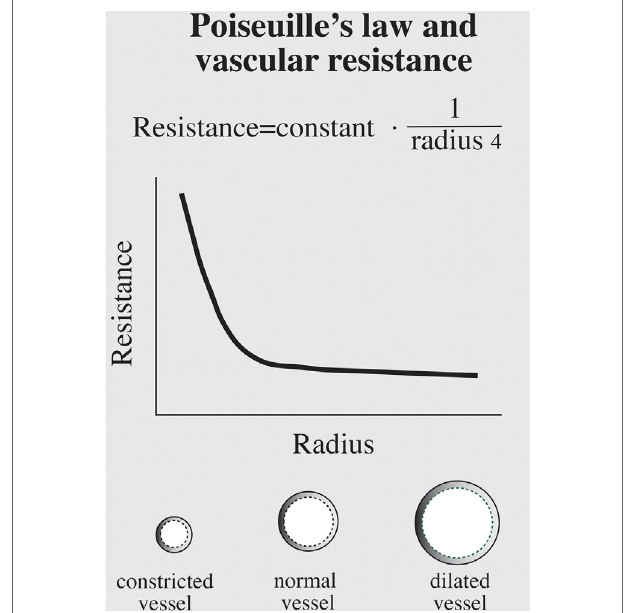
FiGURe 5 | The relation between the flow resistance ( R ) and radius ( r ) of a vessel according to the law of Hagen–Poiseulle. As seen, this is a very unlinear relation ( R = constant × 1/ r 4 ), which means that the effect of a vasoconstrictor is dependent on the initial vascular resistance. The vasoconstriction induced by a vasoconstrictor will be larger in the penumbra zone with a trauma-induced initial vasoconstriction than in less injured